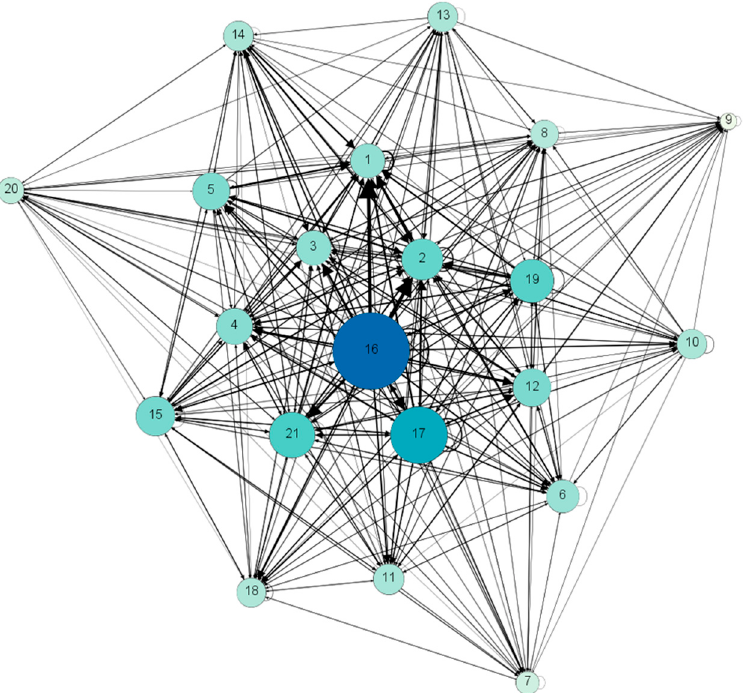
Figure 2. Social network of DT in the olive landscape in Andalusia—Actors emitting knowledge. The size and colour of the nodes indicate the degree of output, the larger and darker the node, the greater the degree of information emission.